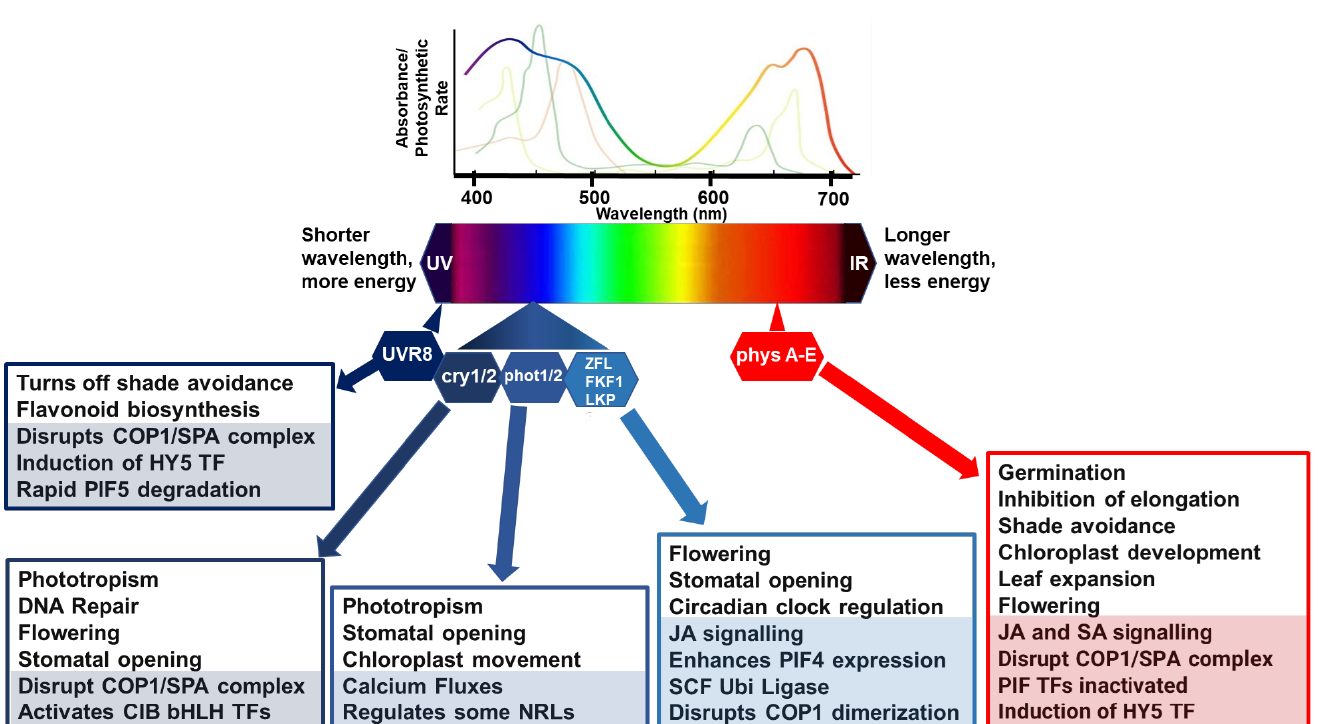
Figure 1. Simplified model of light perception and associated molecular and physiological pro- cesses. Lines, above the light spectrum, represent the light absorption spectra for the major photosyn- thetic pigments, chlorophyll a (lime green), b (apple green) and carotenoids (brown/green line). The rainbow line highlights photosynthetic rate relative to wavelength. Below the light spectra indicates multiple photoreceptors that have evolved to detect blue and red wavelengths. In general, in poor light quality, stabilization of photomorphogenesis-promoting factors occurs, promoting growth in the direction of light. Photomorphogenic responses are regulated by phytochromes (phyA to E), which absorb RL/FRL; cryptochromes (cry 1/2), which are activated by BL/UV-A; phototropins (phot 1/2), activated by BL/UV-A; and Zeitlupe family members (Ztl, fkf1, lkp2) activated by BL/UV-A and the UV-B photoreceptor (UV resistance locus; UVR8). Light activation of phytochromes, cryp- tochromes, and UVR8 promotes interactions with transcription factors to relay responses to light conditions. CONSTITUTIVE PHOTOMORPHOGENIC 1 and SUPPRESSOR OF PHYTOCHROME A (COP1/SPA) complex act as substrate adaptors for CULLIN4 (CUL4) E3 ligase complexes, key repres- sors of light responses in darkness. Under high RL:FRL conditions, ELONGATED HYPOCOTYL 5 (HY5) is induced and Phytochrome-Interacting Factor (PIF) activities are inactivated by phyB to suppress shade avoidance responses such as elongation. Under UV and blue lights, COP1/SPA is disrupted to suppress unnecessary and costly photomorphogenesis responses. UVR8 induces HY5 activity, and the binding of UVR8 to COP1 in UV-B disrupts PIF5 stabilization, rapidly lowering PIF5 abundance in sunlight by degradation via ubiquitination and proteasome-mediated protein degradation. CRYs disrupt the COP1/SPA complex which activates cryptochrome-interacting basic helix–loop–helix (CIB1) and CIB1-related proteins to promote floral initiation, DNA repair, and stomatal opening. Phots have their own kinase activities associated with regulation of physiological responses to optimize photosynthesis, such as stomatal opening to regulate CO 2 uptake and water loss, chloroplast movements, calcium fluxes, and leaf positioning. Activated phots interact with some NRL family members as a substrate adaptor c of a CULLIN3 E3 ubiquitin ligase. Zeitlupe family members disrupt COP1 dimerization, enhance PIF4 expression, and regulate responses such as flowering time, JA biosynthesis, and stomatal opening. COP1/SPA can also target some additional E3 ligases or kinases for degradation causing indirect increases and stabilization of downstream transcription factors, such as PIFs. In each box, the lower shaded sections highlight molecular mechanisms, and the non-shaded, upper sections features physiological